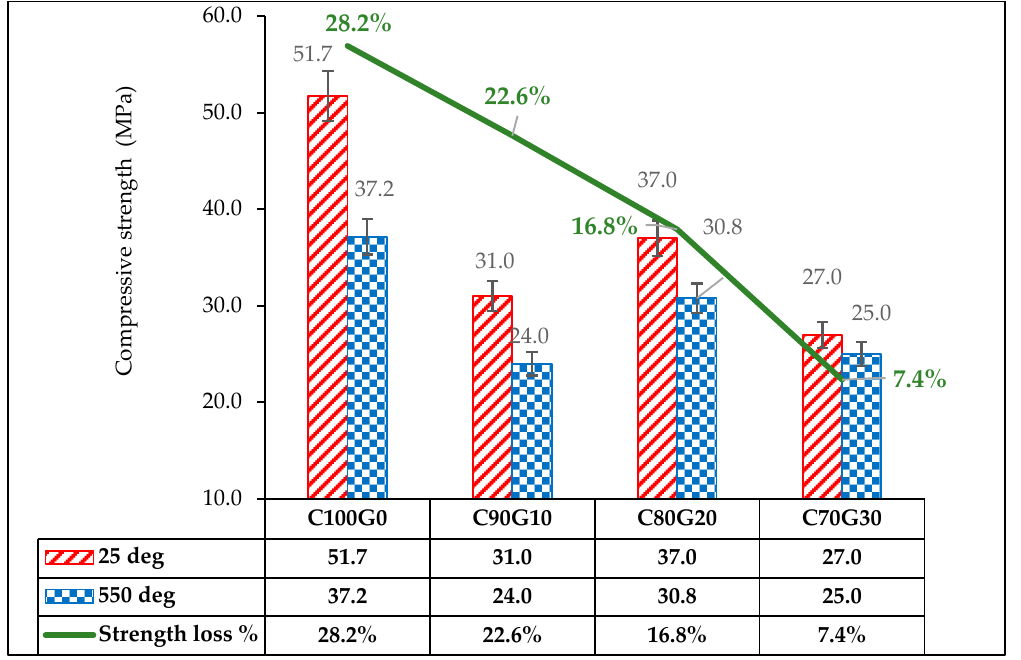
Figure 16. Residual strength of glass blended concrete exposed to elevated temperature.